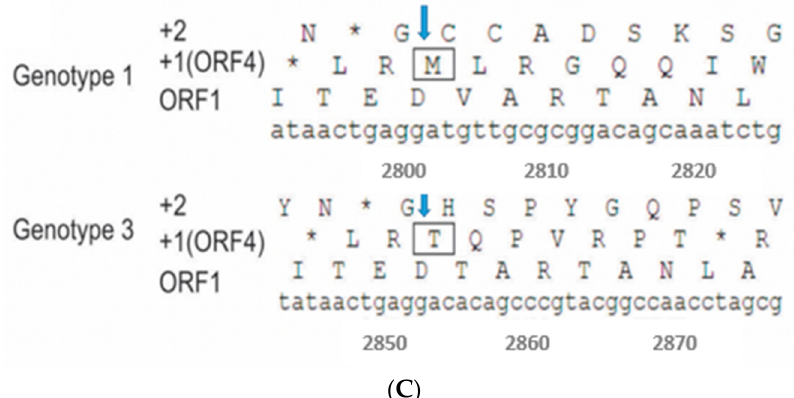
Figure 2. ORF4 within gt1 HEV regulated via IRES-like RNA that is upregulated through endoplasmic reticulum (ER) stress. ( A ) Sequence alignment of the gt1 (GenBank accession no. AF444002) region from 2664 to 2845 bp including IRES sequence compared to homologous sequence of gt3 (GenBank accession no. JQ679013) shows significant sequence homology. ( B ) IRES-like RNA activity is only seen in gt1 HEV. The ratio of nano luciferase (NL) to firefly luciferase (FFL) is compared in gt1 and gt3 IRES-like RNA element sequences in a dual luciferase reporter plasmid, in the presence of tunicamycin (ER stressor). ( C ) Translation maps of HEV ORF1 nucleotides encompassing the +1 frameshifted ORF4 reading frame start methionine from gt1 HEV and the comparable region from gt3. Methionine (blue arrow) the translation initiator amino acid of ORF4 within gt1 HEV is not present at the homologous position of the gt3 HEV. Each bar displays the mean of three independent biological experiments with four replicates per sample (** p < 0.01, t -test).